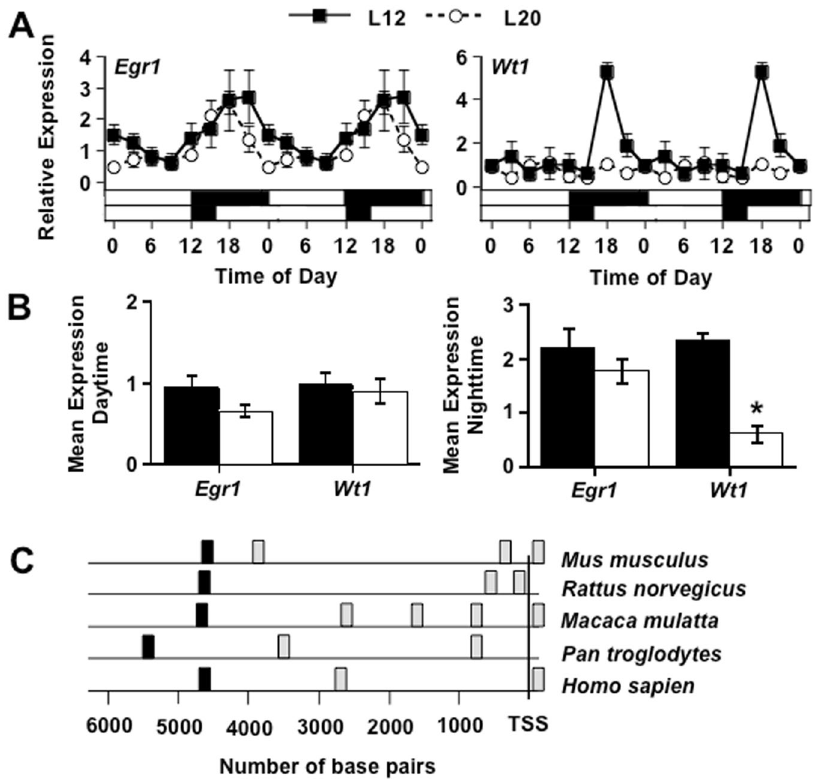
Figure 5. Long days suppress expression of a transcriptional repressor of Igf2 known as Wilm’s tumor1( Wt1) . ( A ) L20 decreased the rhythmic expression of Wt1 , but produced only a modest effect on Erg1 . Note that daily changes in gene expression are double-plotted to facilitate rhythm analysis. Statistical evaluation of transcript rhythms and group differences are described in Table S1. ( B ) Summary of results illustrating that Wt1 expression is reduced at night. ( C ) Sites in the promoter region of Wt1 that contain an E-box (gray, CA(C/T) GT(G/T)) or an RRE (black, AATCTGGGGTCA) in five different mammalian species. TSS = transcriptional start